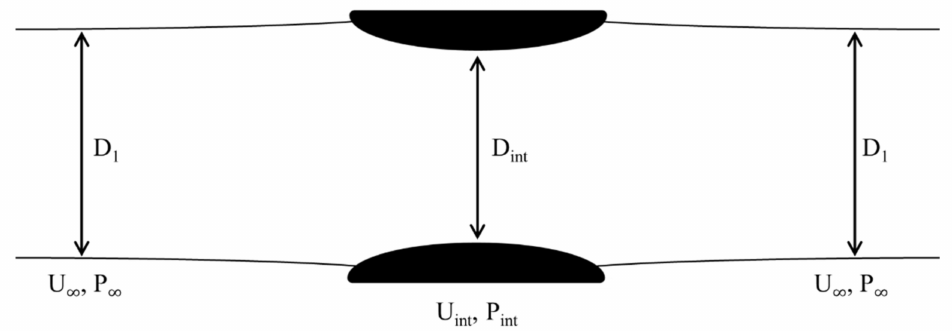
Figure 1. Bi-directional vacant duct streamtube representation.